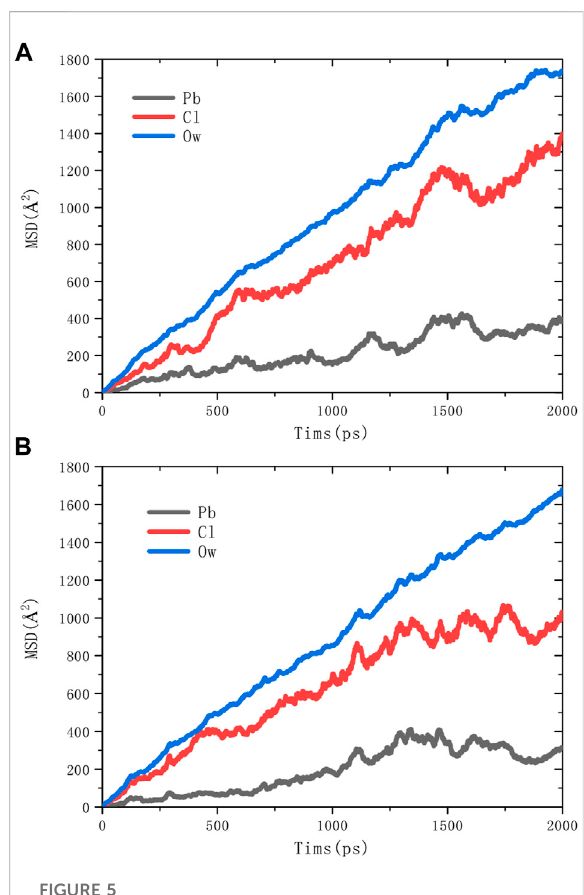
FIGURE 5 The mean square displacement of water and ions: (A) C-S-H 1.7 (B) C-S-H